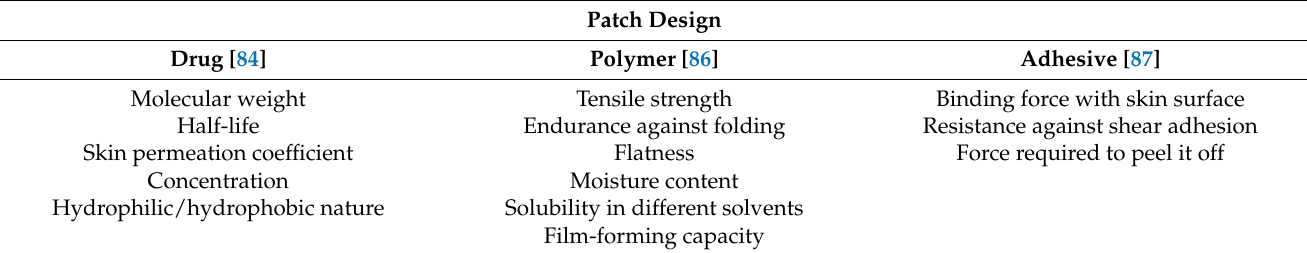
Table 3. Critical parameters in designing the patch. Patch